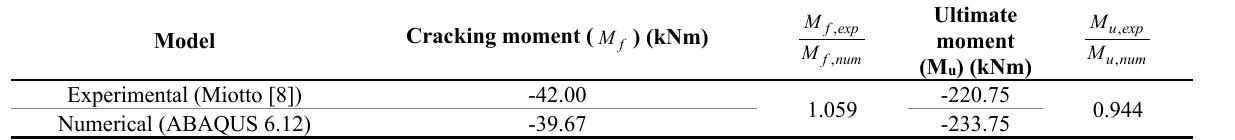
Table 4. Comparisons of numerical and experimental bending moments